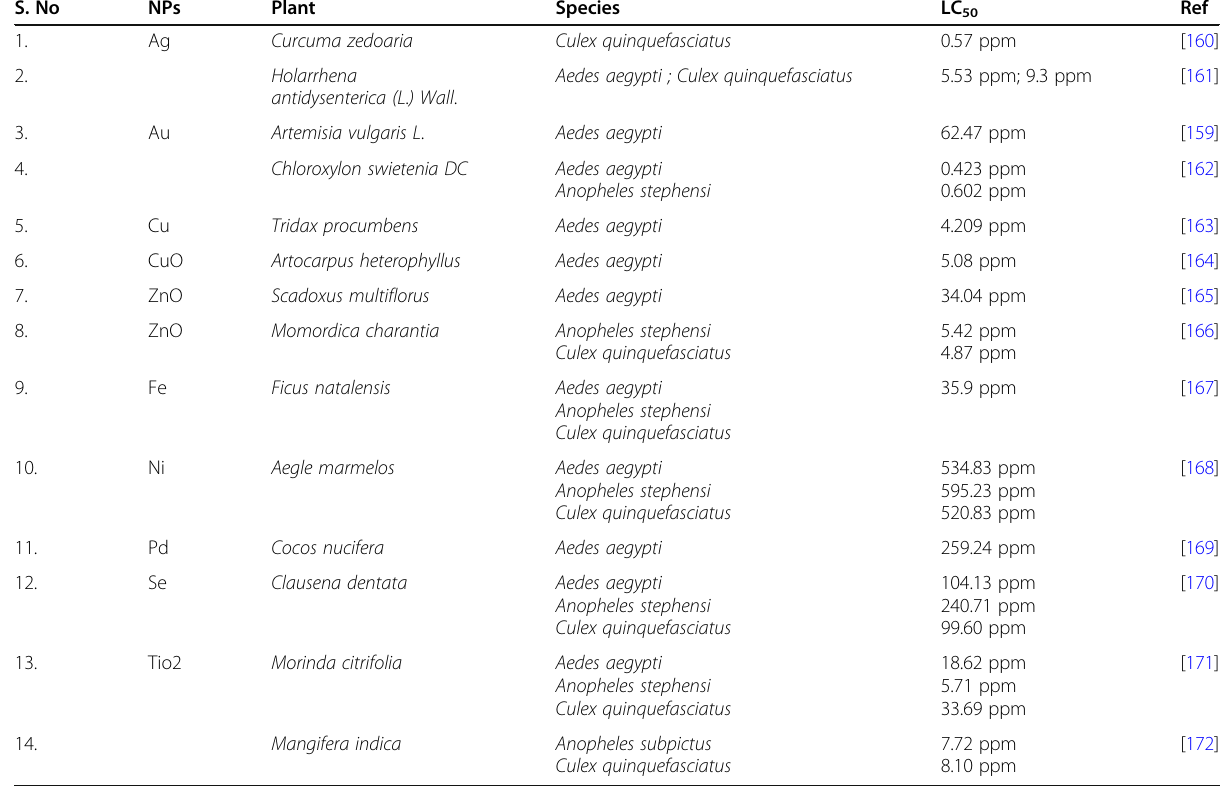
Table 6 Larvicidal activity of metallic nanoparticles synthesized from plant